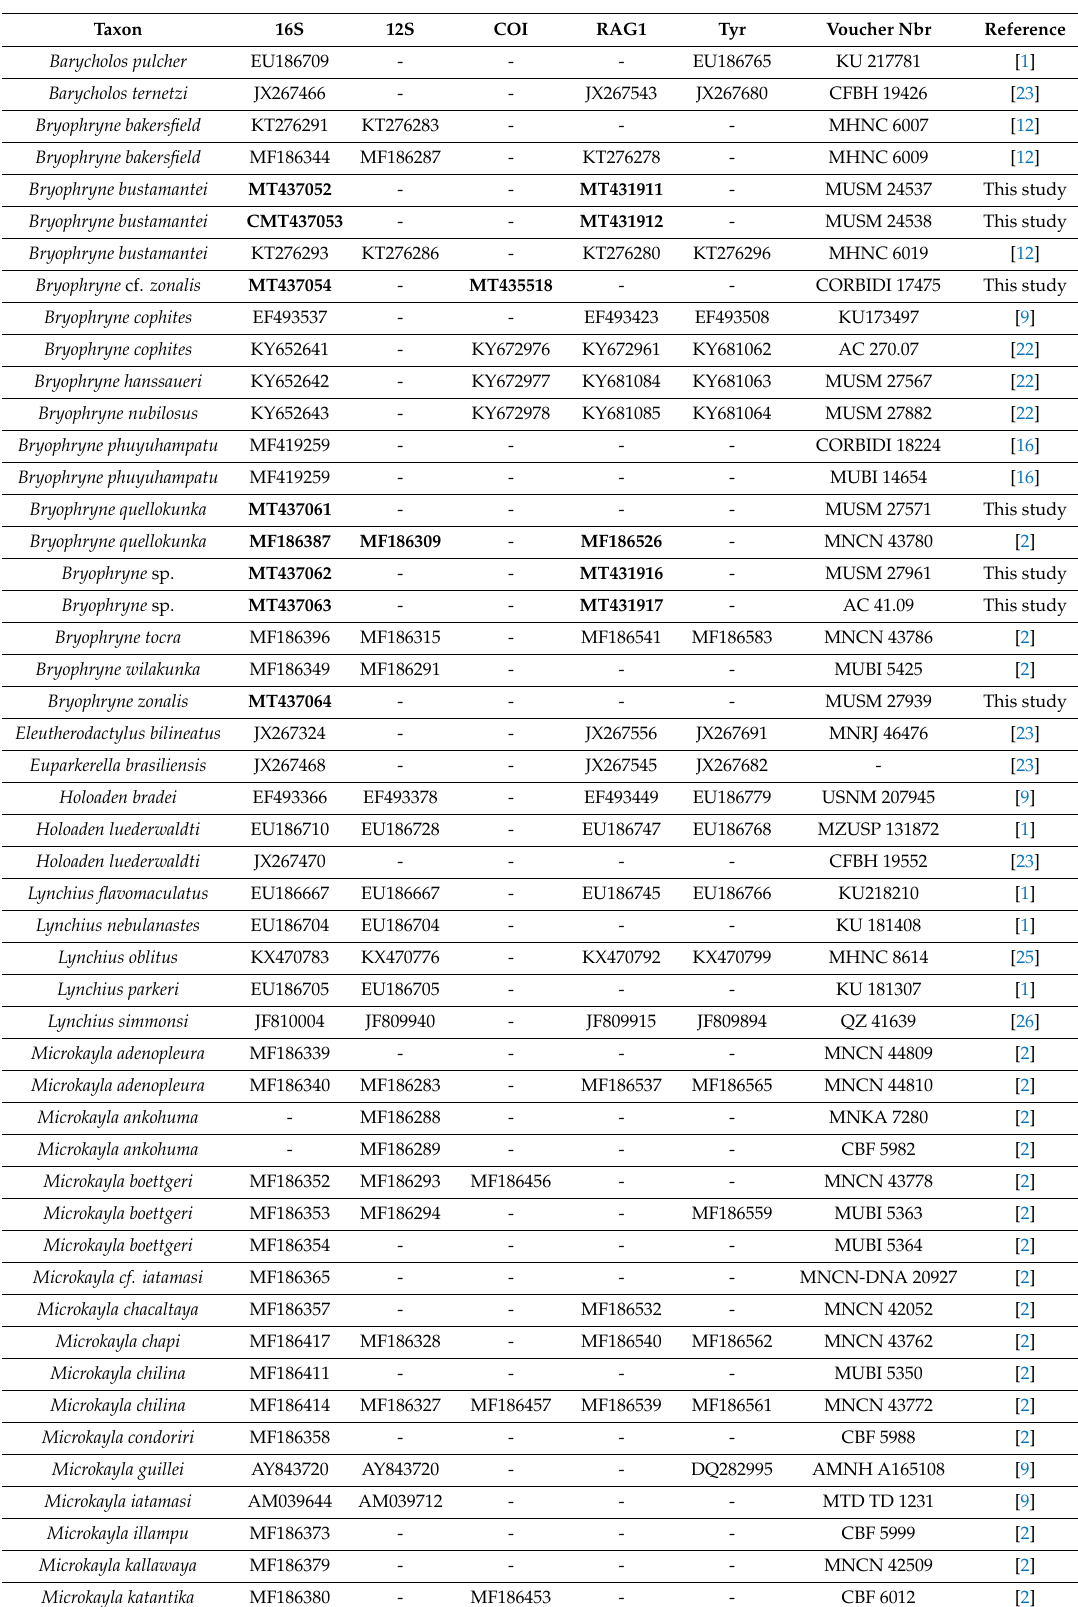
Table 1. GenBank accession numbers for taxa and genes sampled in this study. Genbank accession codes of the new sequences are highlighted in bold